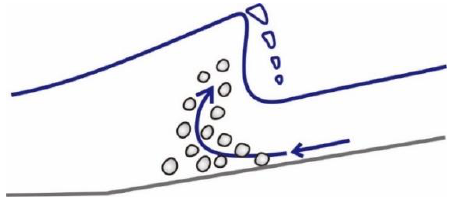
Figure 10. Schematic sketch of entrained sediment particles near the wave breaking line.